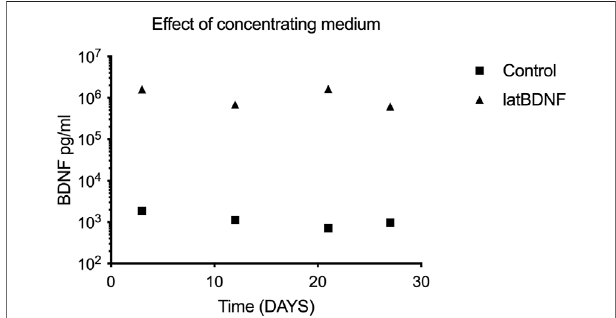
FIGURE 2 | To evaluate differences between control utricle production of BDNF and cultures treated with Ad28.lat.BDNF, a long-term culture experiment was carried out. Medium from the cultures was collected at four timepoints and concentrated via microdialysis. ELISAfor BDNF showed that controls expressed a consistent low level of BDNF, whereas the Ad28.lat.BDNF-treated cultures showed higher levels of BDNF expression.